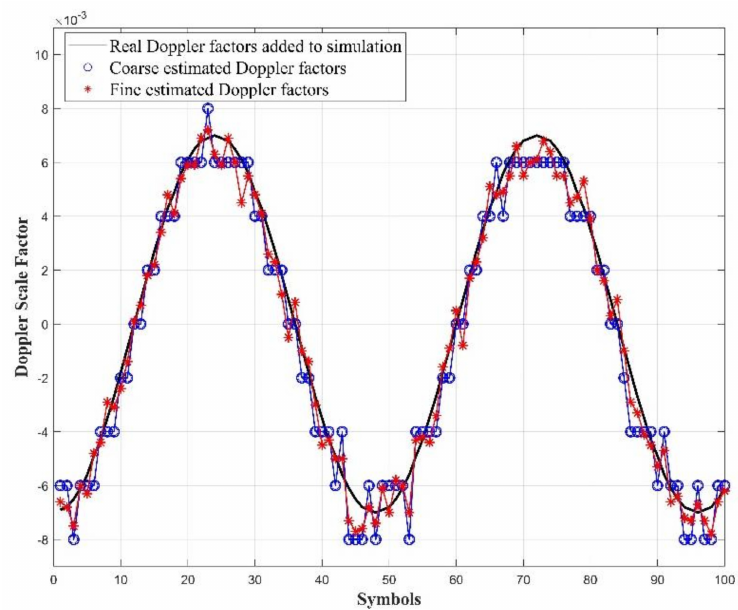
Figure 8. Doppler estimation